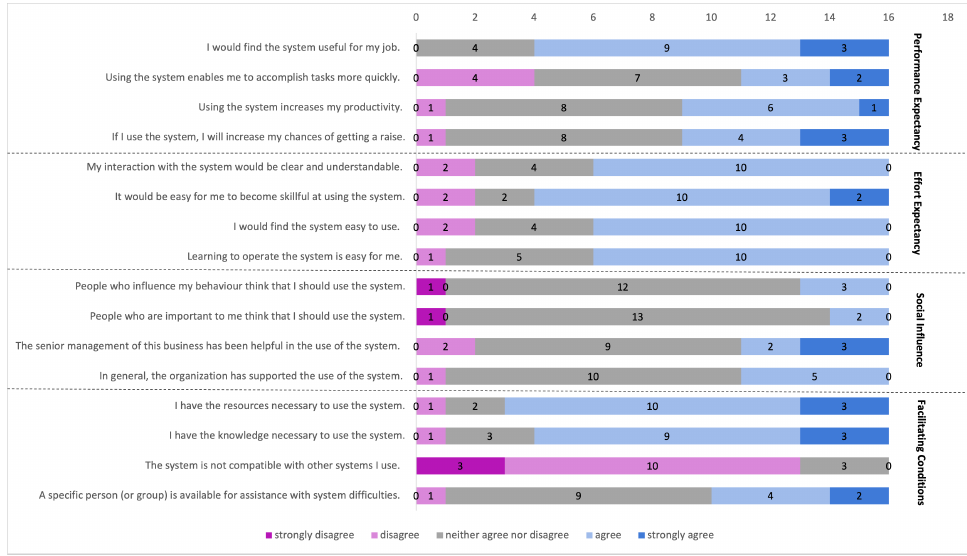
Figure 24. The UTAUT questionnaire result for the analysis of water stress and irrigation requirements use case. Each coloured section indicates the number of participants who responded between ‘strongly disagree’ and ‘strongly agree’ (i.e., frequency).